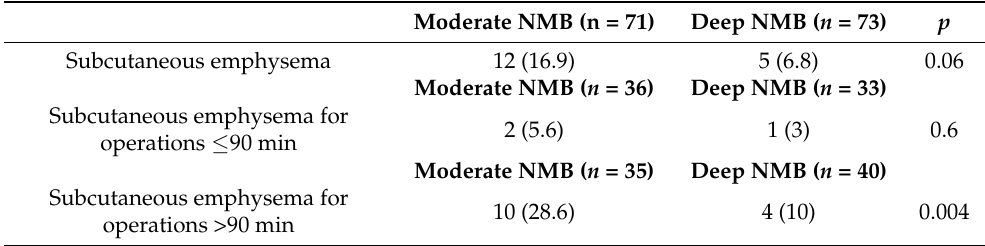
Overall incidents of subcutaneous emphysema and subgroup analysis regarding operation